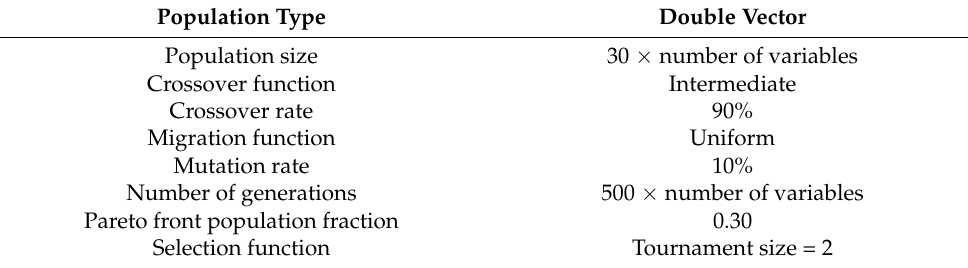
Table 1. Parameters of nondominated sorting genetic algorithm (NSGA